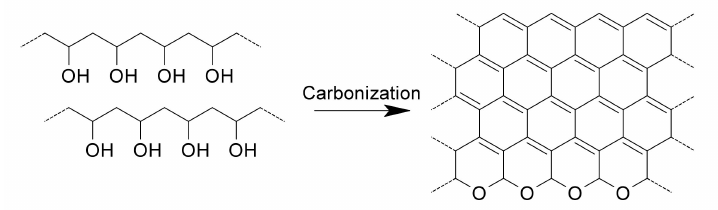
Figure 3. Chemical structure of sp 2 carbon produced after heat treatment of